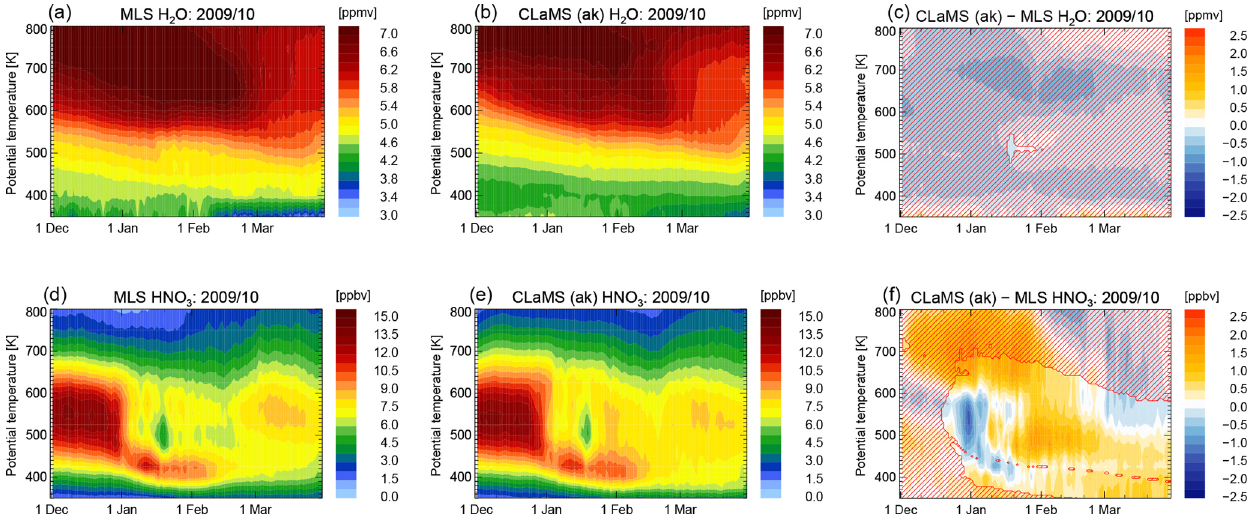
Figure 5. Temporal evolution of water vapor (H 2 O) and nitric acid (HNO 3 ) are shown as an average inside the core of the polar vortex (equivalent latitudes > 70 ◦ N) from 1 December 2009 until 31 March 2010. MLS measurements are presented in (a, d) , CLaMS model results accounting for the MLS averaging kernel in (b, e) , and the difference between MLS and CLaMS in (c, f) . Regions not affected by any changes in the CLaMS sedimentation module are